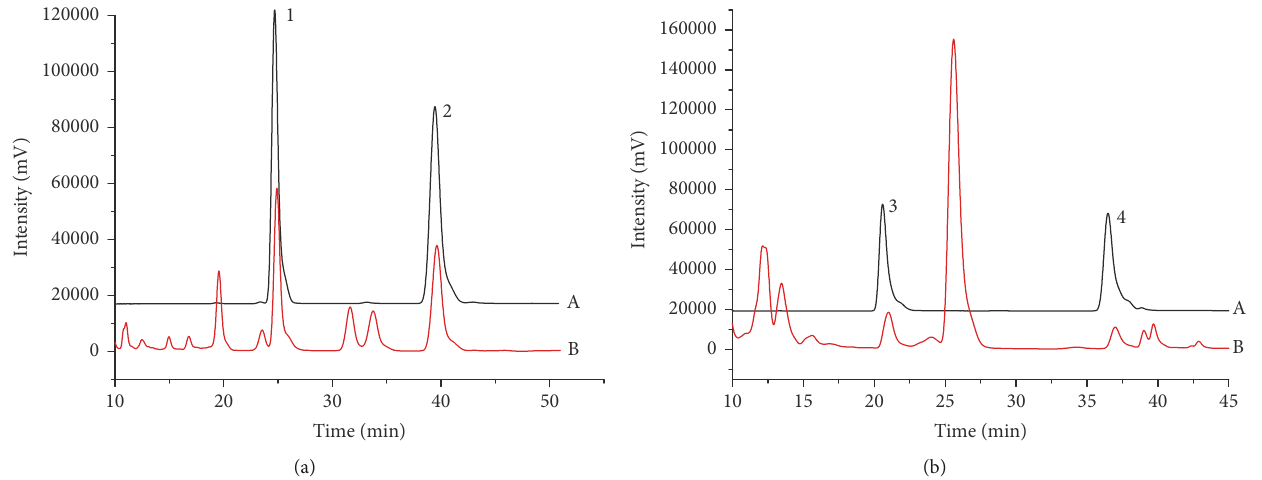
Figure 1: HPLC chromatograms of the standard solution (A) and the sample solution (B): (1) isoquercitrin, (2) astragalin, (3) quercetin, and (4) kaempferol.